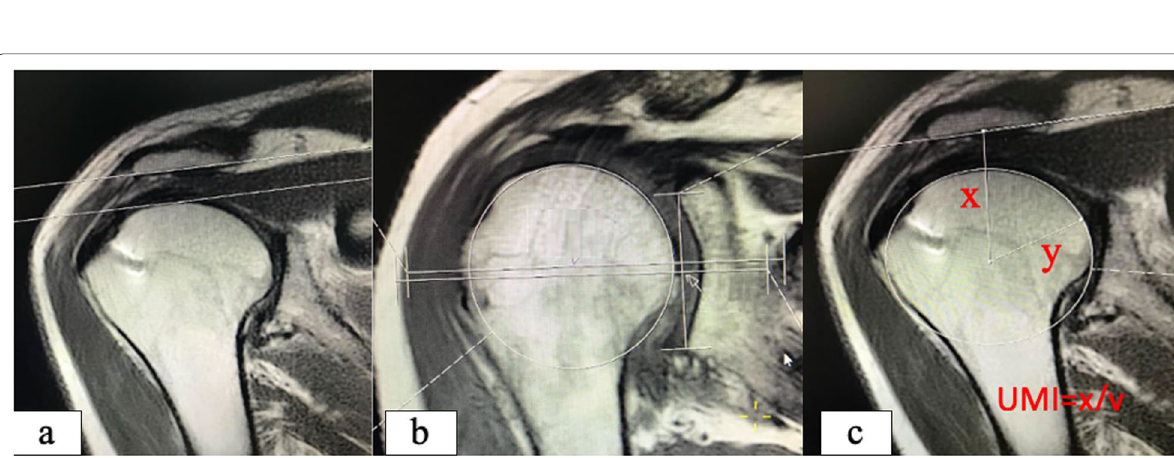
Fig. 3 Radiological measurements at MRI. a Acromiohumeral distance measurements, b Humeral migration measurements, c Upper migration index formula and measurements. a AHD was defined as the distance between the lowest border of the acromion and the humeral head’s highest point. b HM value, the humeral head center, was determined by drawing a tangent circle to the humeral head’s boundaries. Then, the glenoid fossa was determined by the line drawn between the superior and inferior most edges of the glenoid, and then the center of the glenoid fossa was marked on this line. A second line was drawn from the center of the humeral head perpendicular to the glenoid fossa line, and the intersection point was marked. The distance between the intersection point and the center of the glenoid fossa was recorded as the HM. If the center of the glenoid fossa was inferior to the intersection point, the HM was recorded as a negative value. If it was superior, then the HM took a positive value. c The UMI, where the distance between the center of the humeral head to the acromion’s undersurface was divided by the humeral head’s radius, as described by Hirooka et